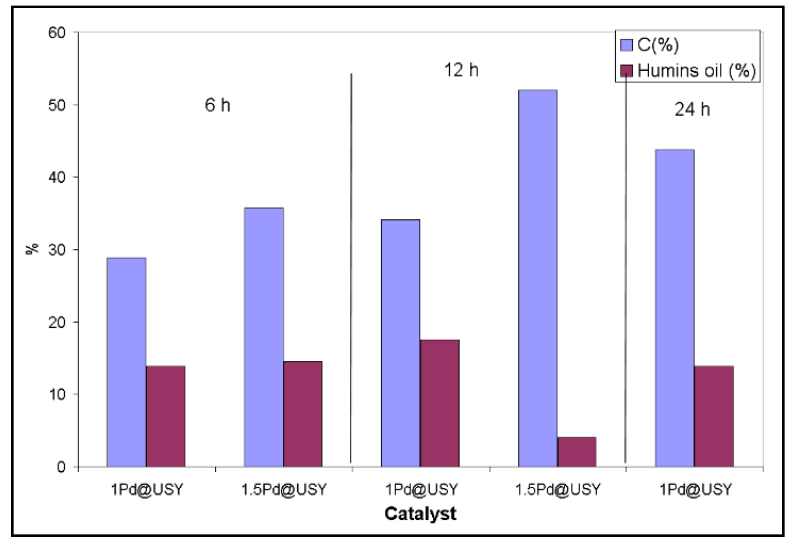
Figure 14. Catalytic performances of the Pd@USY catalysts in the hydrodeoxygenation of humins (reaction conditions: 0.1 g humins, 10 mg of catalyst, 8 mL IPA, 30 bars, T = 250 °C).